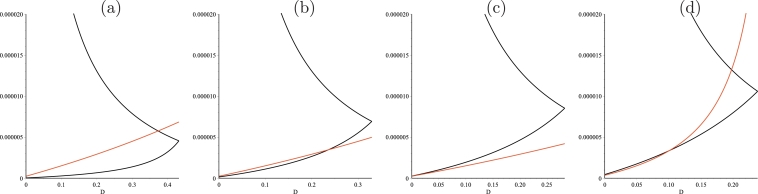
Graphs of s20(D) and s21(D) (in black) and M2(D+a2) (in red) and graphical depiction of I1=[0,D1), where D1 is the solution of s20(D)=s21(D), and I2. (a): I2=[0,D2) where D2 is the solution of M2(D+a2)=s21(D). (b) : I2=[0,D2) where D2 is the solution of M2(D+a2)=s20(D). (c): I2 is empty. (d) : I2=(D2min,D2max) where D2min and D2max are the solutions of M2(D+a2)=s20(D) and M2(D+a2)=s21(D), respectively. Cases (a)–(d) are obtained with the numerical parameter values listed in Tables 2 and 3. (For interpretation of the references to colour in this figure legend, the reader is referred to the web version of this article.)